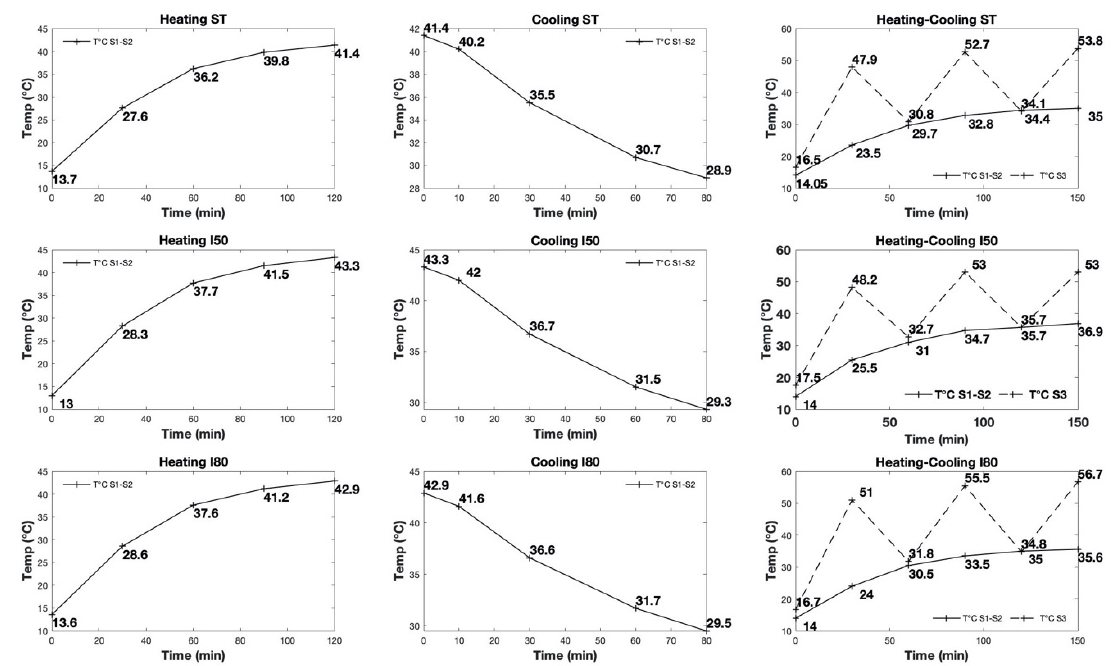
Figure 6. Results of the thermal test in standard (ST) and innovative probes (I50–I80): heating step, cooling step, heating- cooling step.